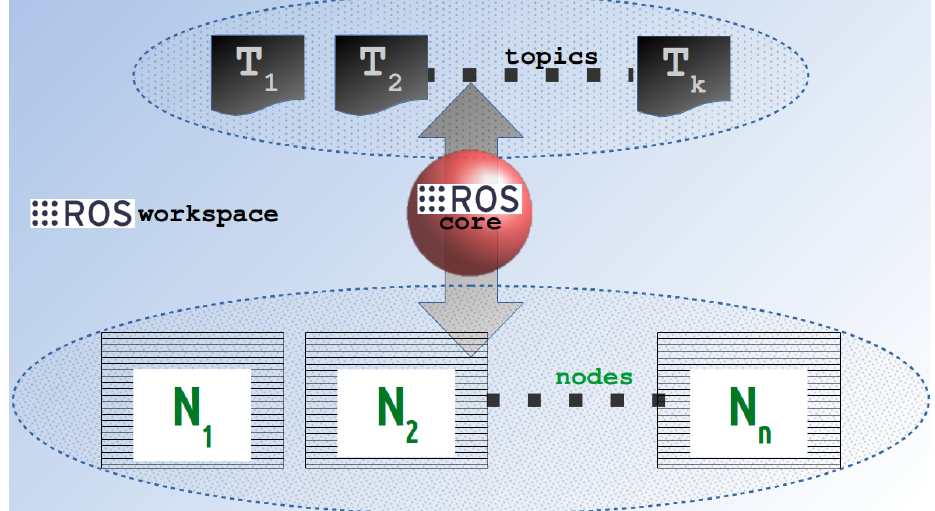
Figure 4. ROS programs are organized in program nodes. Each node may be a publisher or a subscriber to certain message topics. The messaging procedure is time scheduled and